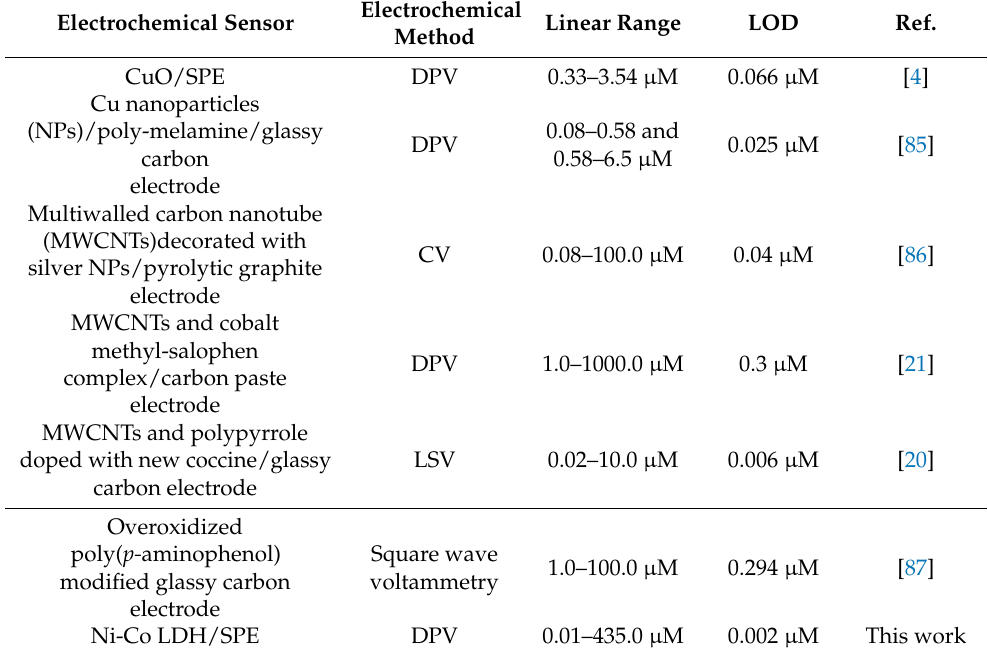
Figure 10. DPVs captured for the oxidation of variable sumatriptan contents on the Ni-Co LDH/SPE under variable contents (a–p: 0.01, 1.0, 2.5, 7.5, 15.0, 30.0, 45.0, 75.0, 100.0, 150.0, 200.0, 250.0, 300.0, 350.0, 400.0, and 435.0 µ M). Inset: Calibration curve of voltammetric response (Ipa) against sumatriptan level. Table 1. Comparison of the efficiency of the Ni-Co LDH/SPE sensor with other reported modified electrodes for sumatriptan